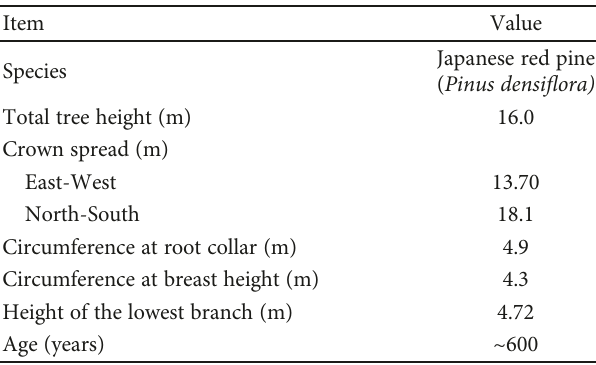
Figure 3: Finite element models for the tree stem and FRP wraps. Table 1: Speci fi cation of Jung-yi-pum-song